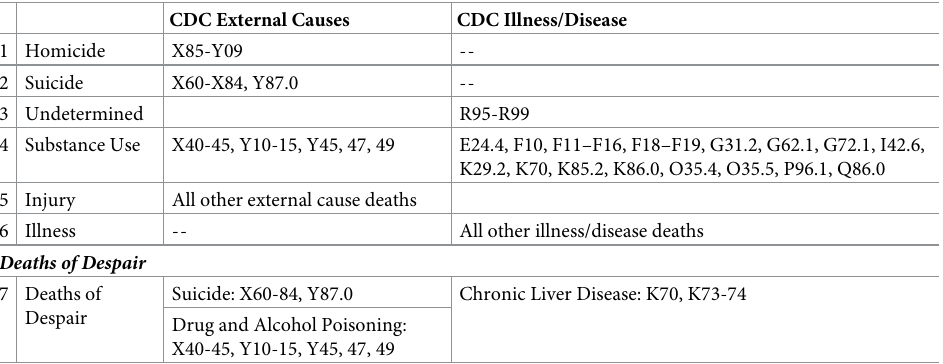
Table 1. Categorization of ICD-10 codes for the Santa Clara County general population cause of death between 2011–2019. Categories 1–6 are primary categories that were identified from CDC WONDER Underlying Causes of Death database. Category 7 is constructed based on the deaths of despair